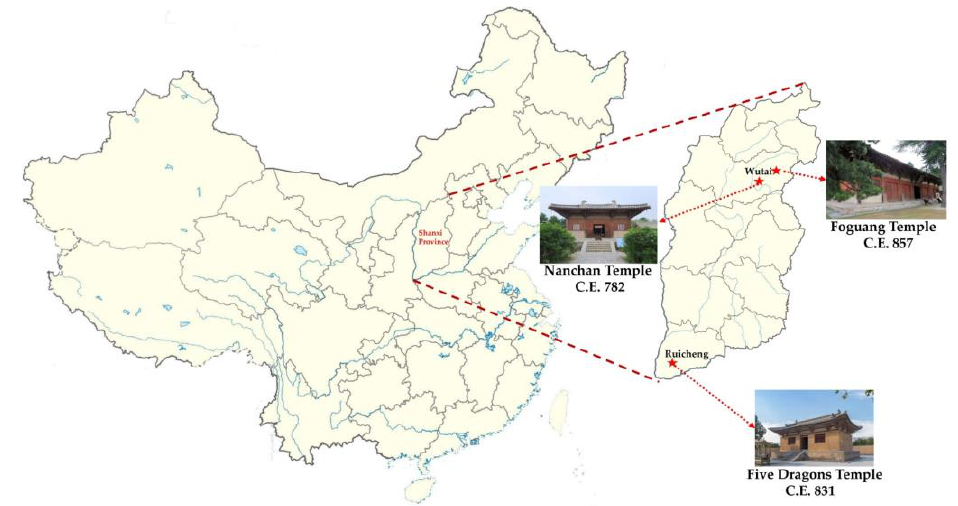
Figure 1. Location of the three Tang Dynasty timber-framed buildings (source: Wikipedia, modified by the authors). Table 1. General description of the comparison of the halls *.